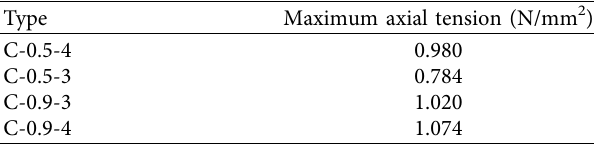
Table 6: The axial test results for 4 foamed concrete panels.